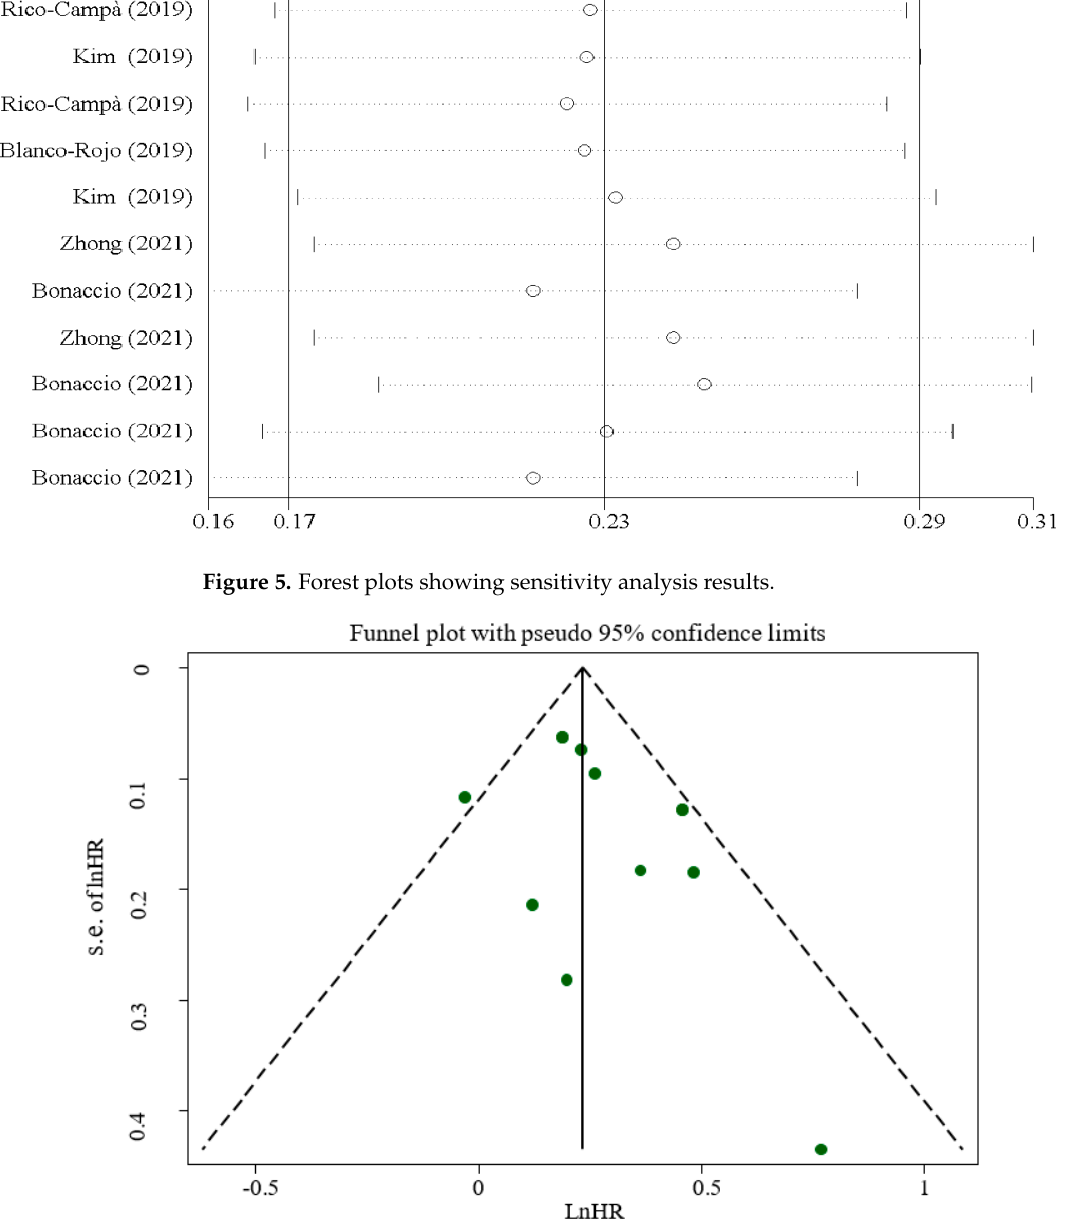
Figure 6. Funnel plot for evaluation publication bias.